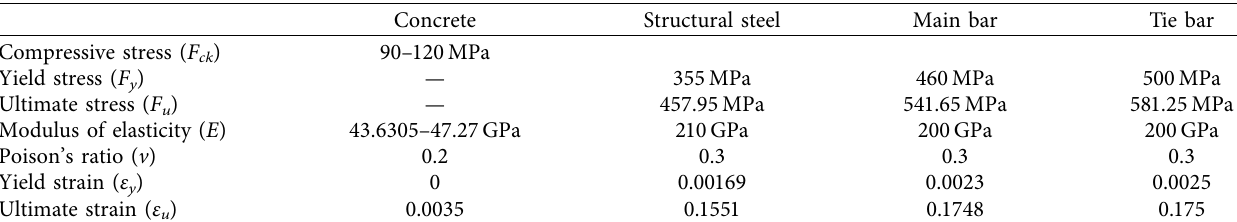
Table 4: Material properties of column specimens for the current study [6, 14].